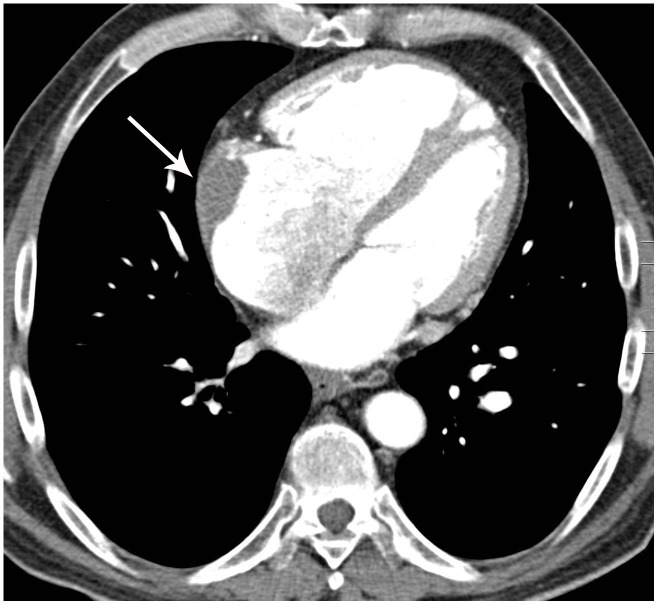
Cardiac thrombi in patients with CTEPH.Axial MDCTA image shows wall-adherent thrombus (arrow) in the right atrium.